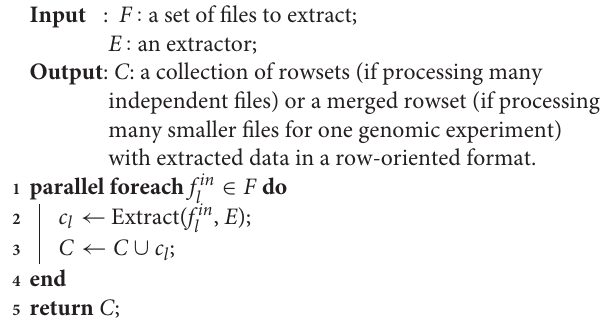
Algorithm 2: Parallelization of NGS data extraction from files located in big NGS data